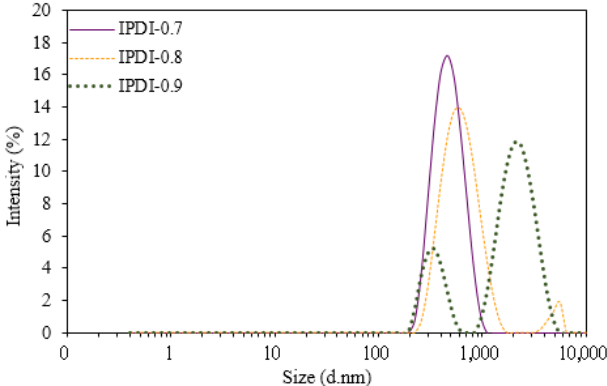
Figure 9. Particle size distributions of WUOs synthesized using IPDI and different NCO/OH mole ratios.